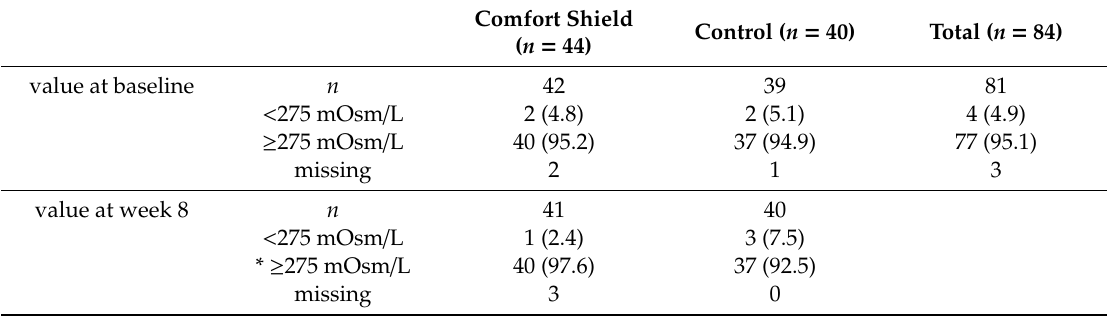
Table A3. Osmolarity: Value in mOsm / L at baseline and at week 8—PPS ( n = 84)–Descriptive analysis, by treatment arm.